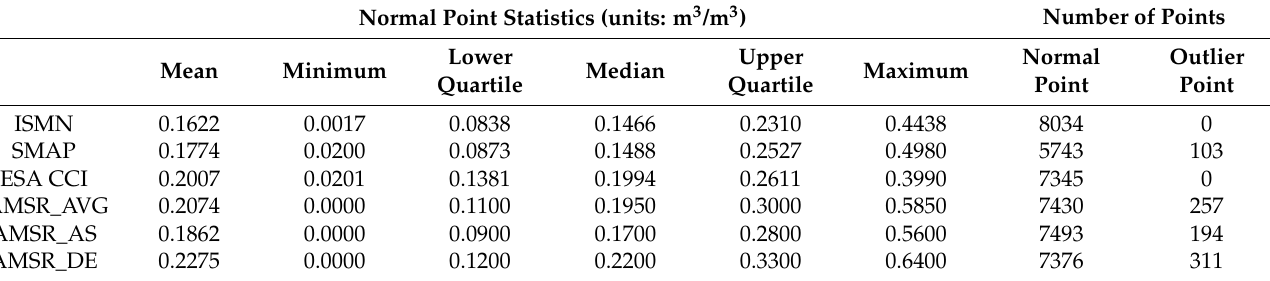
Table 5. Statistics of five